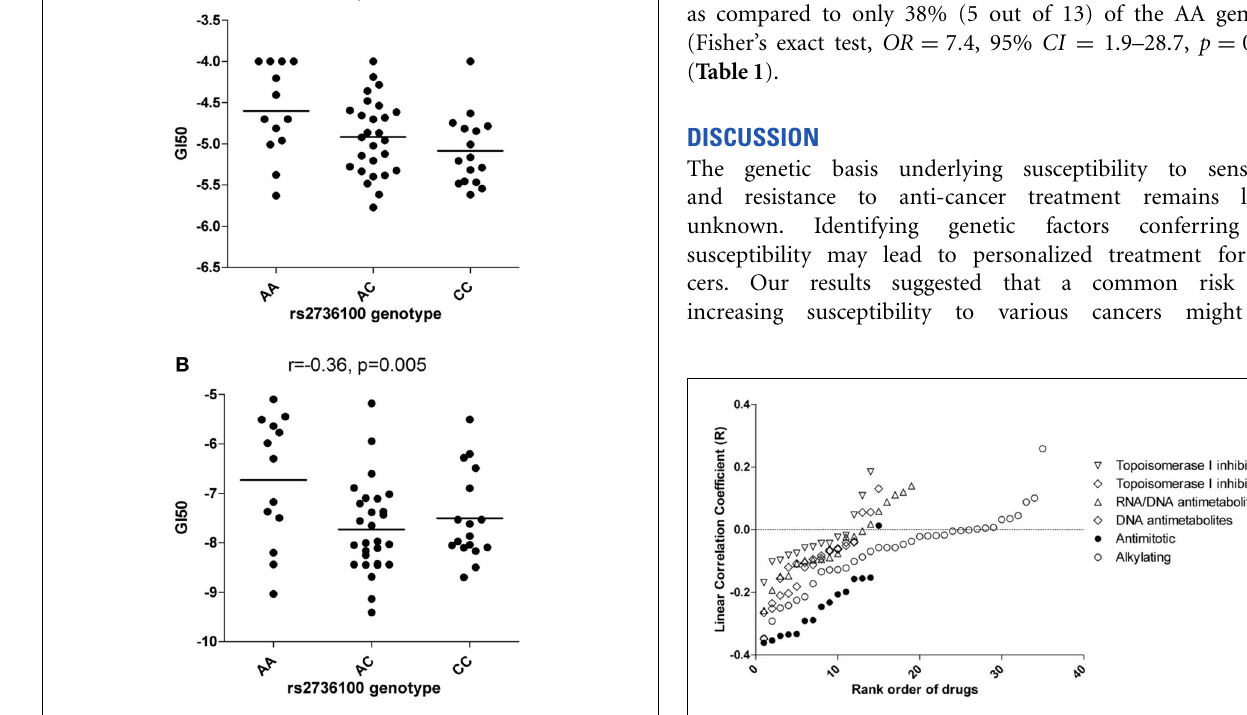
FIGURE 1 | Correlations between rs2736100 and cytotoxicity of RHPS4/BRACO19 (A) and paclitaxel (B). SNP genotype was correlated with drug cytotoxicity data by assigning each genotype (AA, AC, and CC) to 0, 1, and 2 (additive model), 0, 0, and 1 (receive model) or 0, 1, and 1 (dominant model) according to the number of C allele. The horizontal bars indicate the mean value of each group. Linear correlation coefficient (r) and p -value are indicated as well.